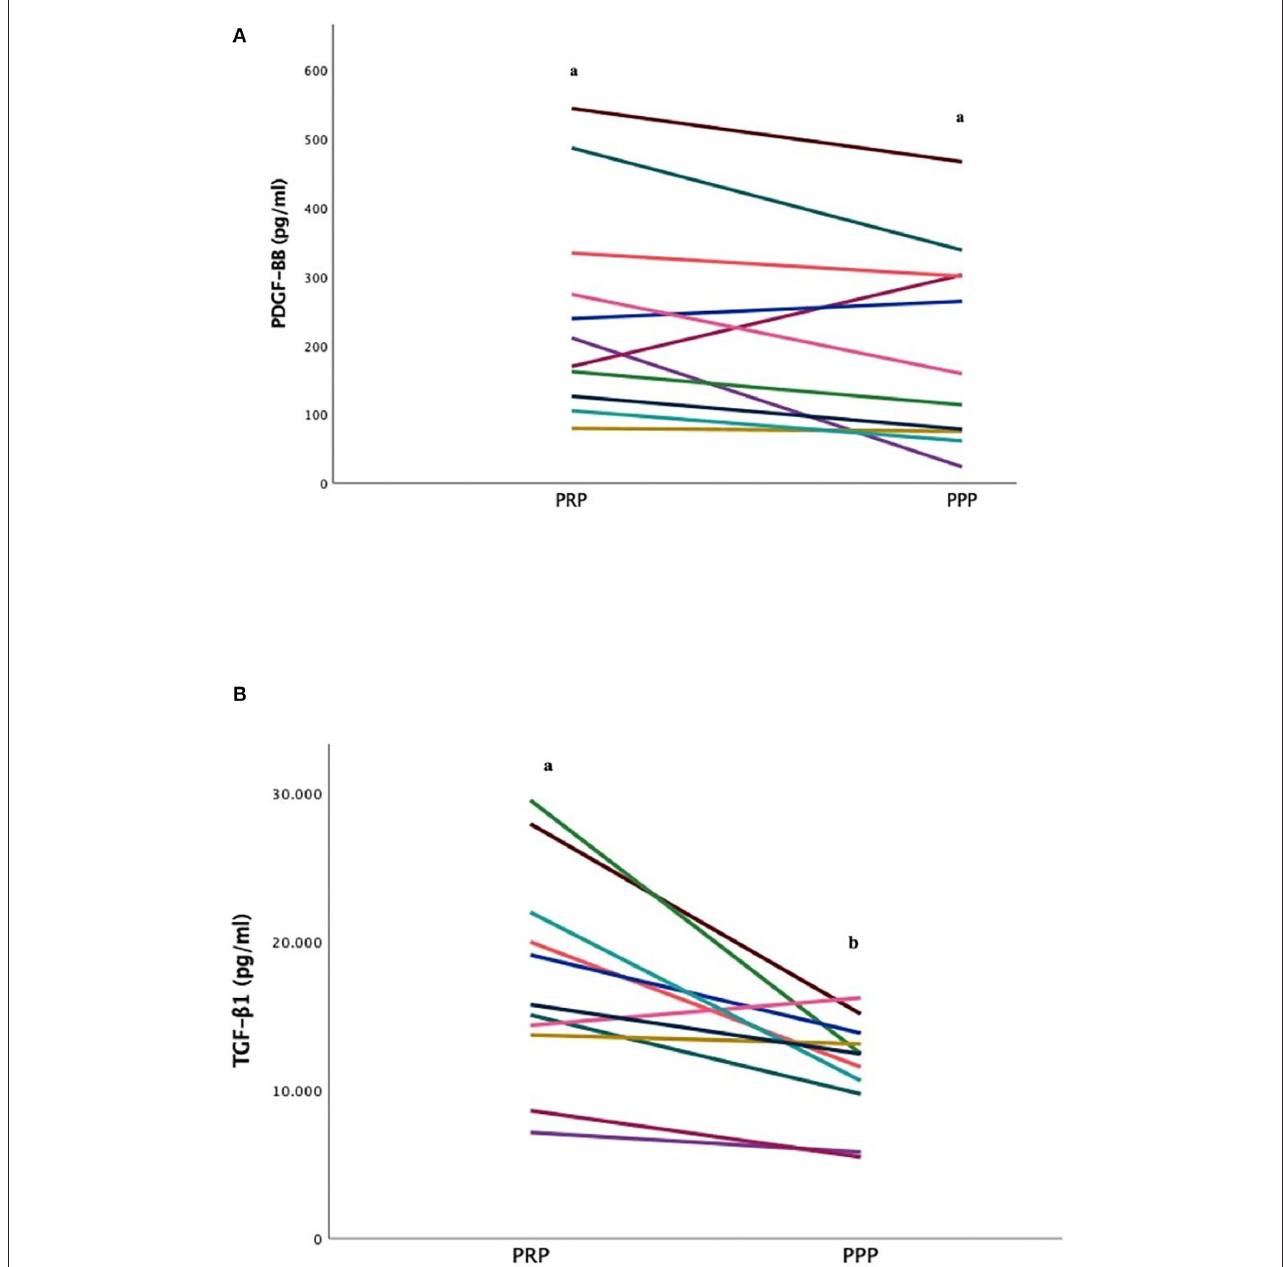
FIGURE3 Comparison of Platelet-Derived Growth Factor-BB [PDGF-BB; (A) ] and transforming growth factor ß1 [TGF-ß1; (B) ] concentrations (mean ± SD) in FeLV cats ( n = 11) between PRP and PPP fractions. Different letters (a, b) indicate differences between groups. P < 0.05 statistically